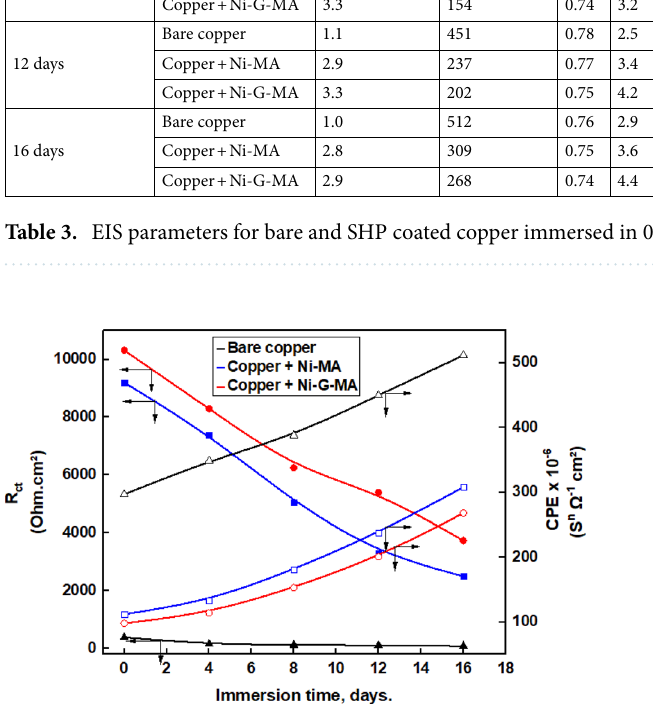
Figure 12. Variation of the charge transfer resistance and constant phase element of the bare and SHP coated copper as a function of immersion time.